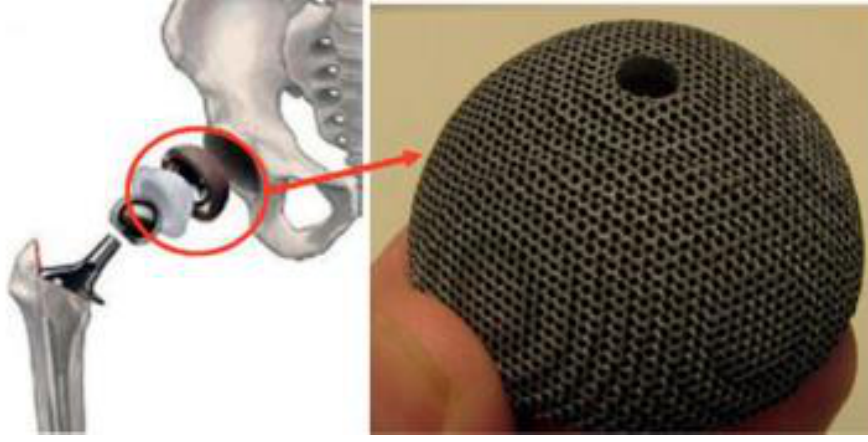
Figure 14. Application of porous Ni-Ti components in bone implants [3].